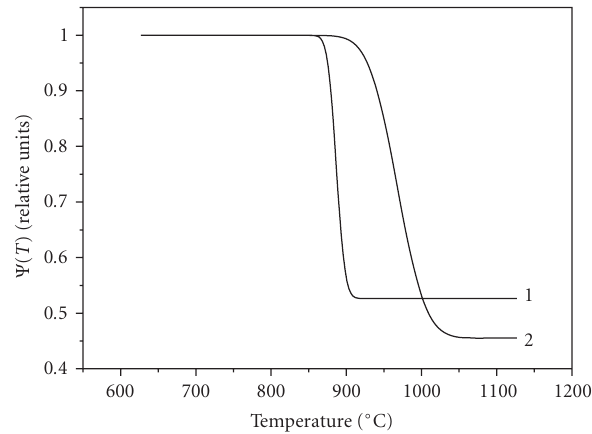
Figure 8: Temperature dependences of the functions Ψ ( T ) for sam- ple A (curve 1) and sample B (curve